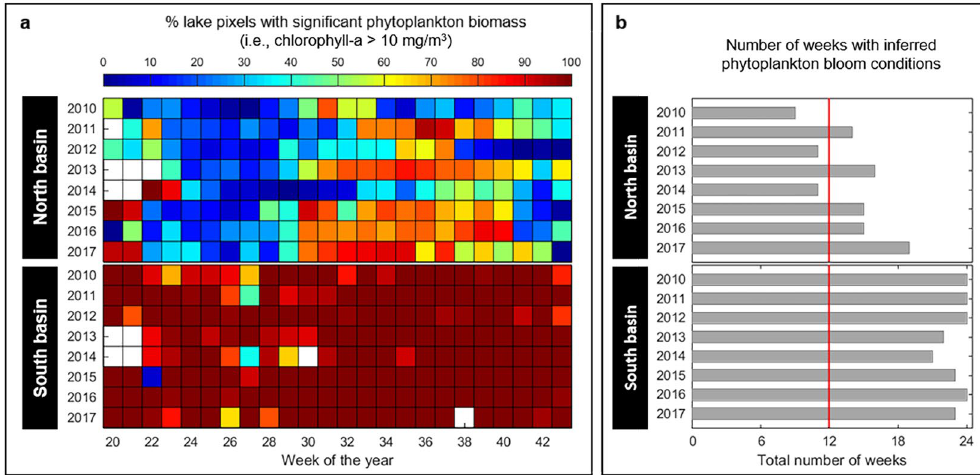
Figure 2. Phytoplankton blooms in Lake Winnipeg. ( a ) Weekly assessment of the percent lake pixels covered by significant phytoplankton biomass for the north and south basins of Lake Winnipeg. ( b ) Yearly number of weeks with phytoplankton bloom conditions. The red line signals the half-way mark (12 weeks) of the open water, ice-free period. The plots were created using MATLAB (version R2016a,